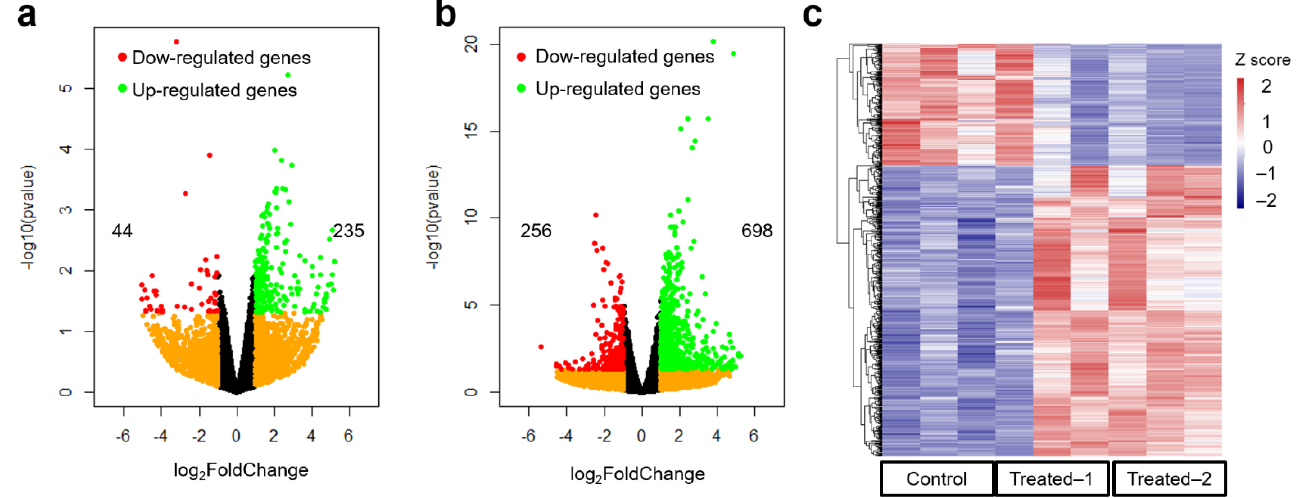
Figure 2. RNA sequencing analysis of HC11 cells post treatment. ( a ). Gene profile of cells ( n = 3 per group) post treatment. Intervention dosage is set as 0.5 J/cm 2 . In total, 44 genes and 235 genes were identified as downregulated and upregulated differentially expressed genes, respectively. ( b ). Gene profile of cells post treatment. Intervention dosage is set as 1.0 J/cm 2 . In total, 256 genes and 698 genes were identified as downregulated and upregulated differentially expressed genes, respectively. ( c ). Heatmap of differentially expressed genes with different intervention. Gene expression was normalized using z-score method. Threshold value to consider as significant difference was set as FDR q < 0.05 and |log 2 FoldChange| ≥